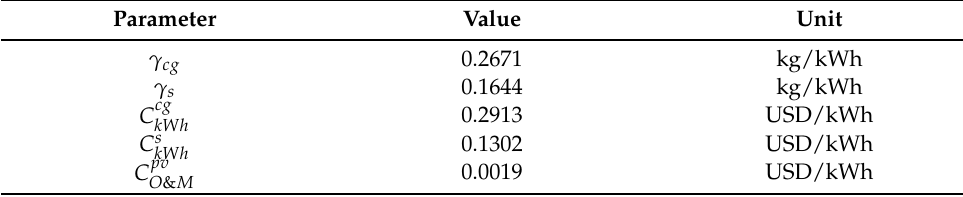
Table 2. Parametrization of the objective